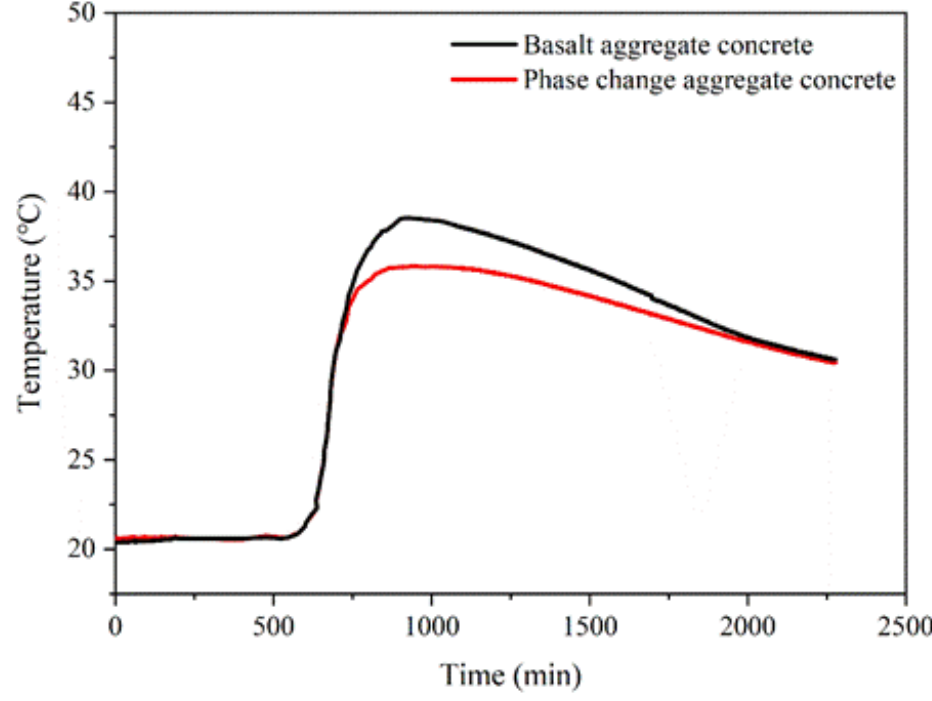
Figure 13. Early hydration temperature rises the curve of concrete.